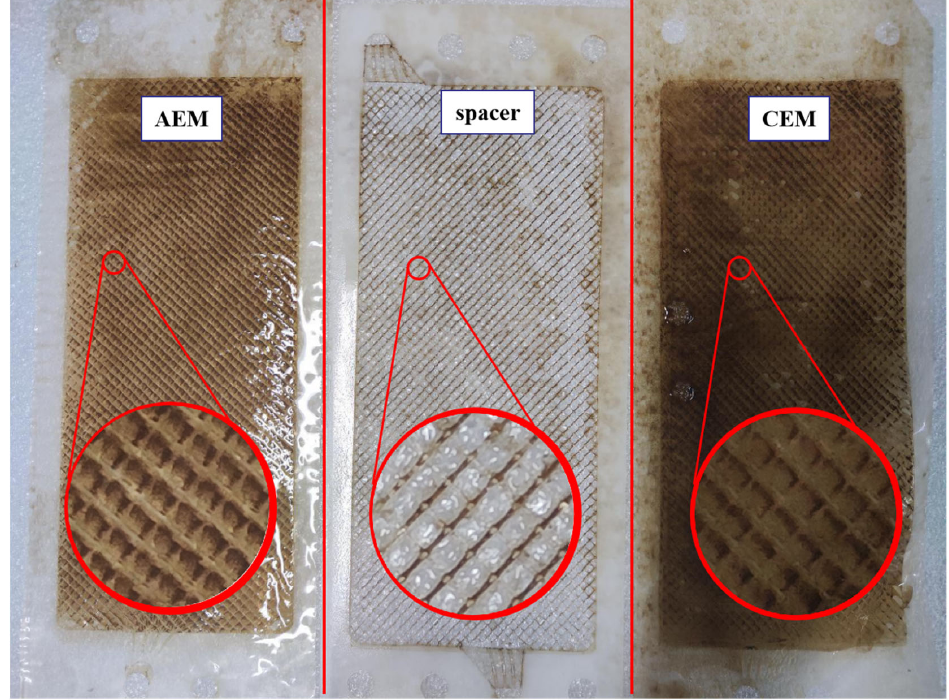
Figure 9. Photograph of fouled membrane components.